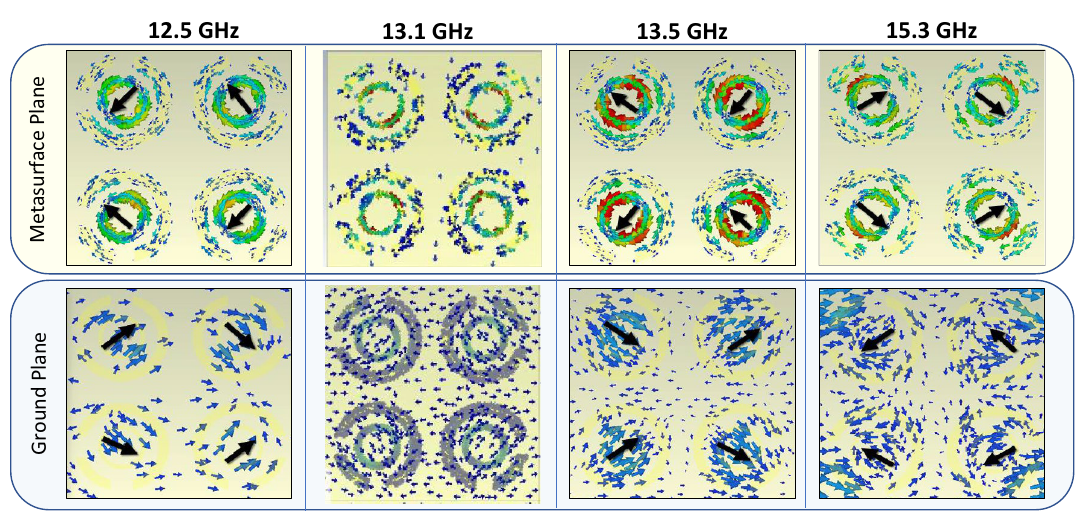
Figure 5. Surface current distribution for supercell at various frequencies 12.5 GHz, 13.5 GHz (absorption resonance) and 15.3 GHz (2nd narrowband absorption